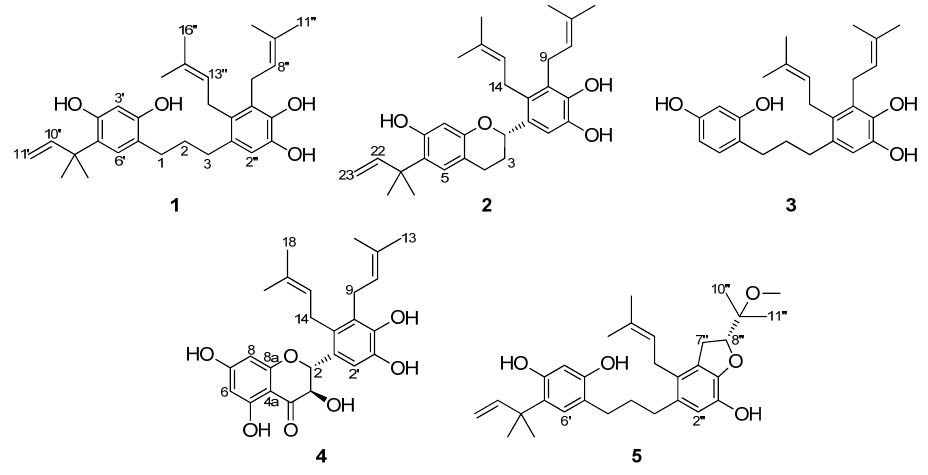
Figure 1. Chemical structures of compounds 1 – 5